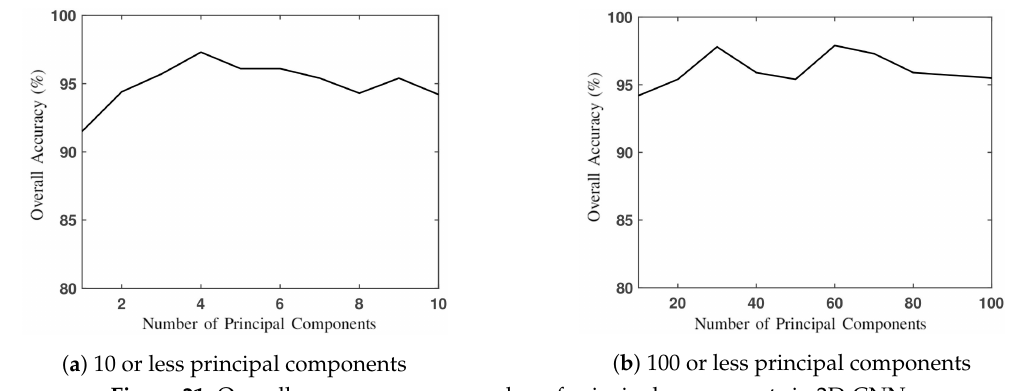
Figure 21. Overall accuracy versus number of principal components in